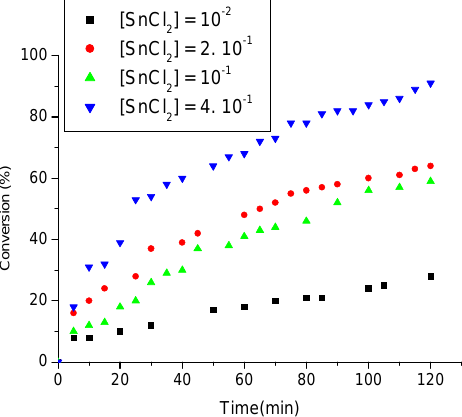
Figure 4 . Effect of the concentration of SnCl oleic acid